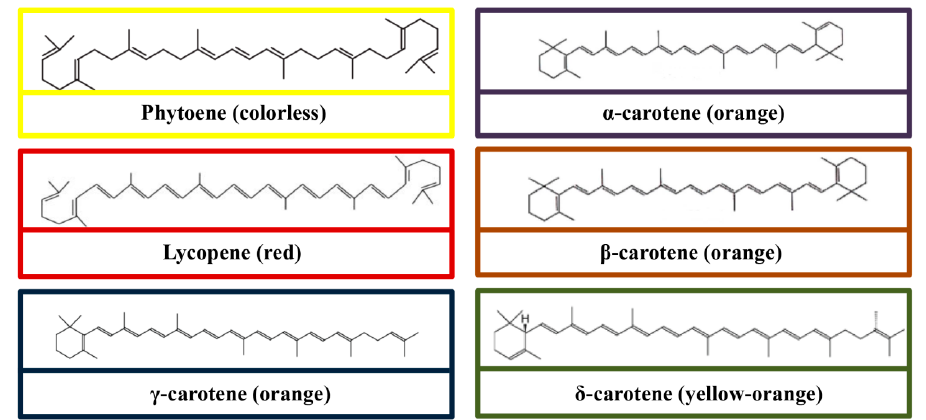
Figure 1. Molecular structures of carotenes (Phytoene, lycopene, γ -carotene, α -carotene, β -carotene, and δ -carotene).